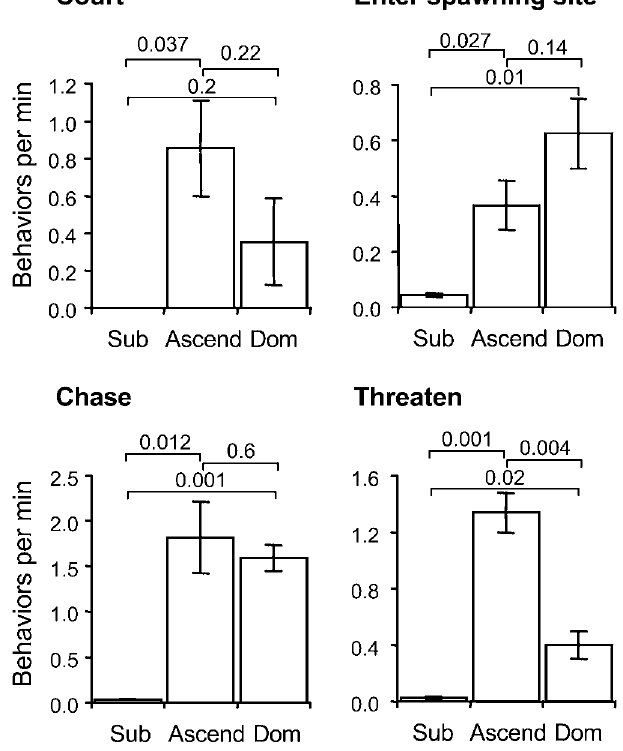
Figure 2. Behavioral Responses to Social Opportunity The rate of individual dominance behaviors per minute (mean 6 SE) differed among stable subordinate (Sub), ascending (Ascend), and stable dominant (Dom) males. p- Values for individual comparisons are shown above